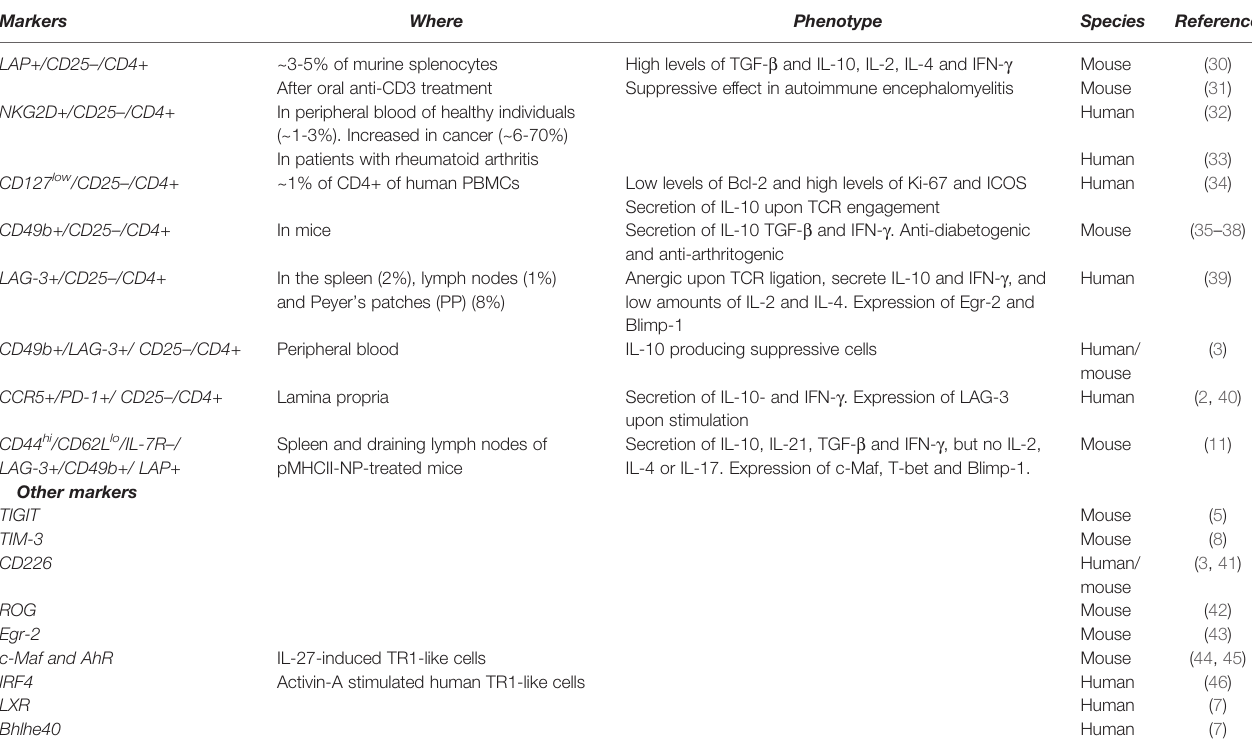
TABLE 1 | Summary of phenotypes ascribed to TR1-like cells. Markers